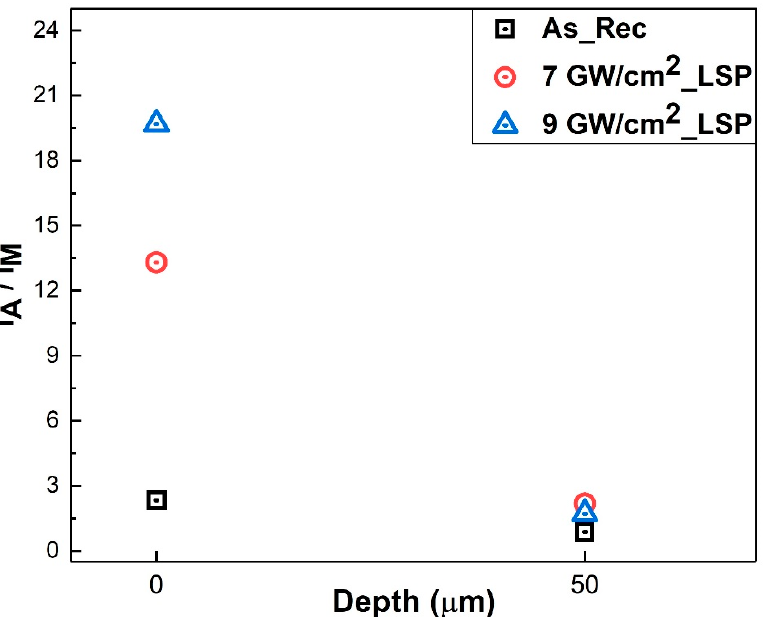
Figure 4. Plot of the intensity ratio of the (110) X-ray peak of austenite and (111) X-ray peak of martensite phase for the as-received, 7 and 9 GW/cm 2 samples. The intensity ratio was determined for X-ray experiments conducted on the surface and on samples taken 50 μ m depth.